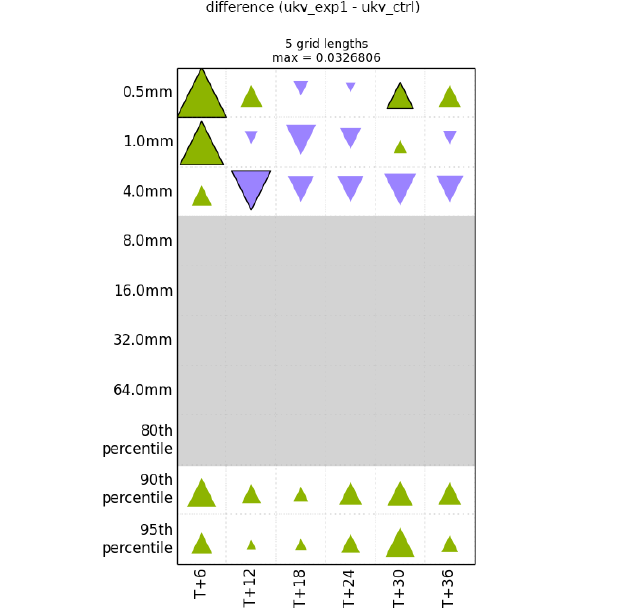
Figure 11. FSS at five grid lengths for 6h